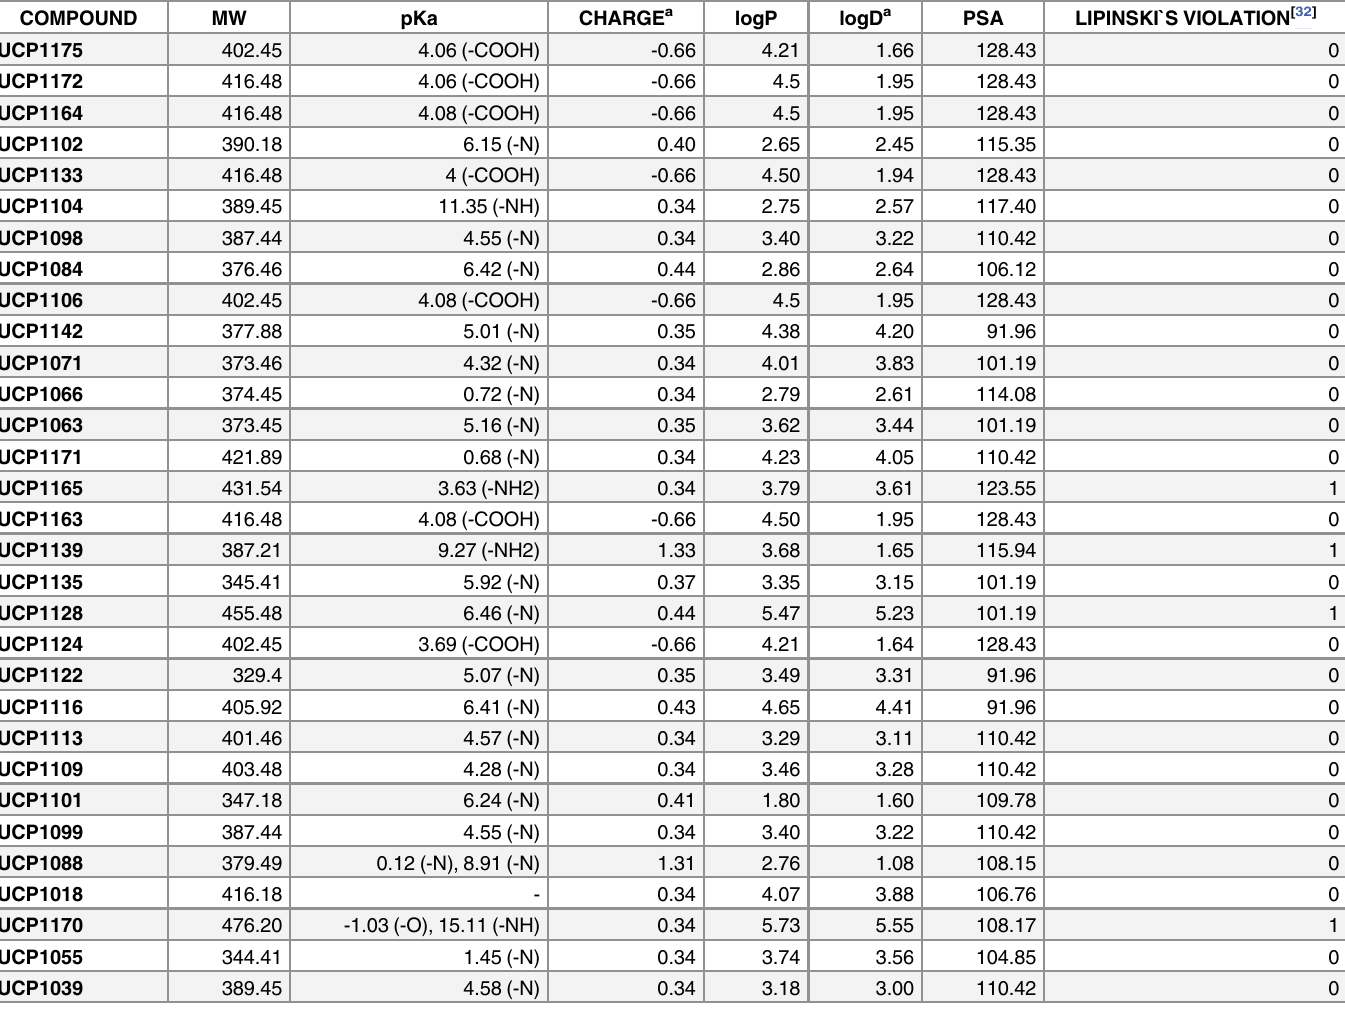
Table 2. Physicochemical properties of